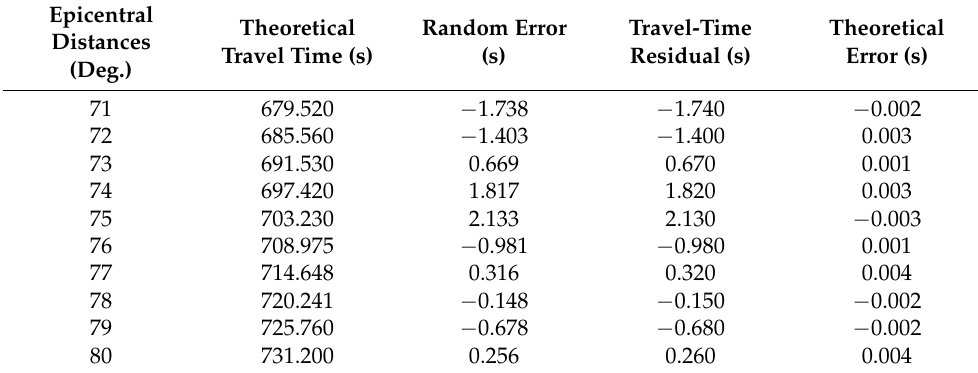
Table 1. Random time error of adding 5% to the traveltime.